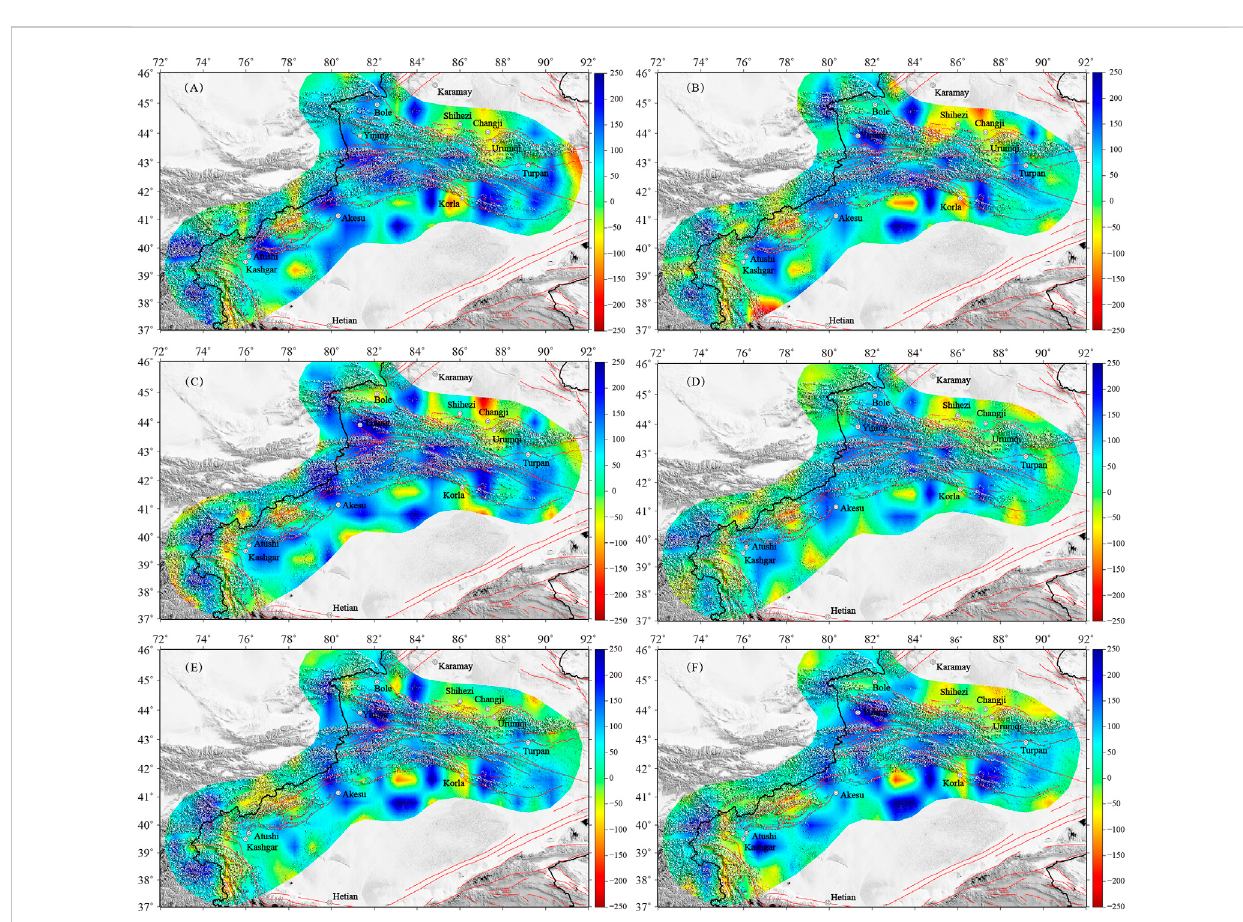
FIGURE 8 Temporal variations in theS-wave-derived Q valuesof theTianshantectonic belt (TTB) for thesix 2-year periods considered in thisstudy. (A) 2009- 2010, (B) 2011 – 2012, (C) 2013 – 2014, (D) 2015 – 2016, (E) 2017 – 2018, and (F) 2019 –